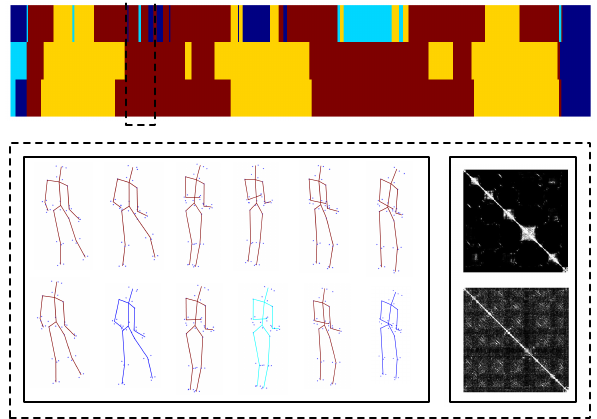
Figure 2. Subspace analysis on 3D human motions. On the top of this figure, three colour bars represent the subspace clustering results. In each bar, the same colour means same cluster. From the top down, the clustering results are obtained from the affinity matrices yielded by LRR [33], KLRR citeXiaoTNNLS15 and our method, respectively. For the first two rows, the LRR and KLRR are applied to the 3D motions ’p1_grab_3’ from the UMPM benchmark. For the third row, the affinity matrix produced from the reconstruction process is exploited. On the bottom, two rows of 3D motions and the clustering in a short and consecutive interval are visualized in a dash-line box. The first row is produced by KLRR and the second one is from LRR. The corresponding affinity matrices are shown on the right